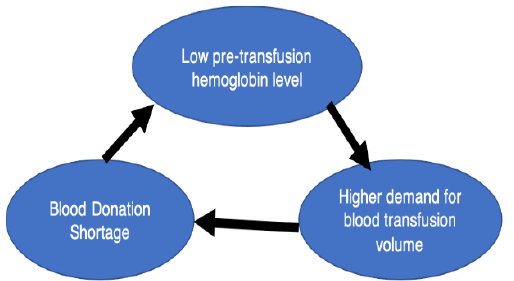
Figure 2. Cycle of having low pre-transfusion hemoglobin levels, requiring a higher volume of blood transfusion, while faced with worldwide blood donation shortage due to COVID-19 pan- demic.